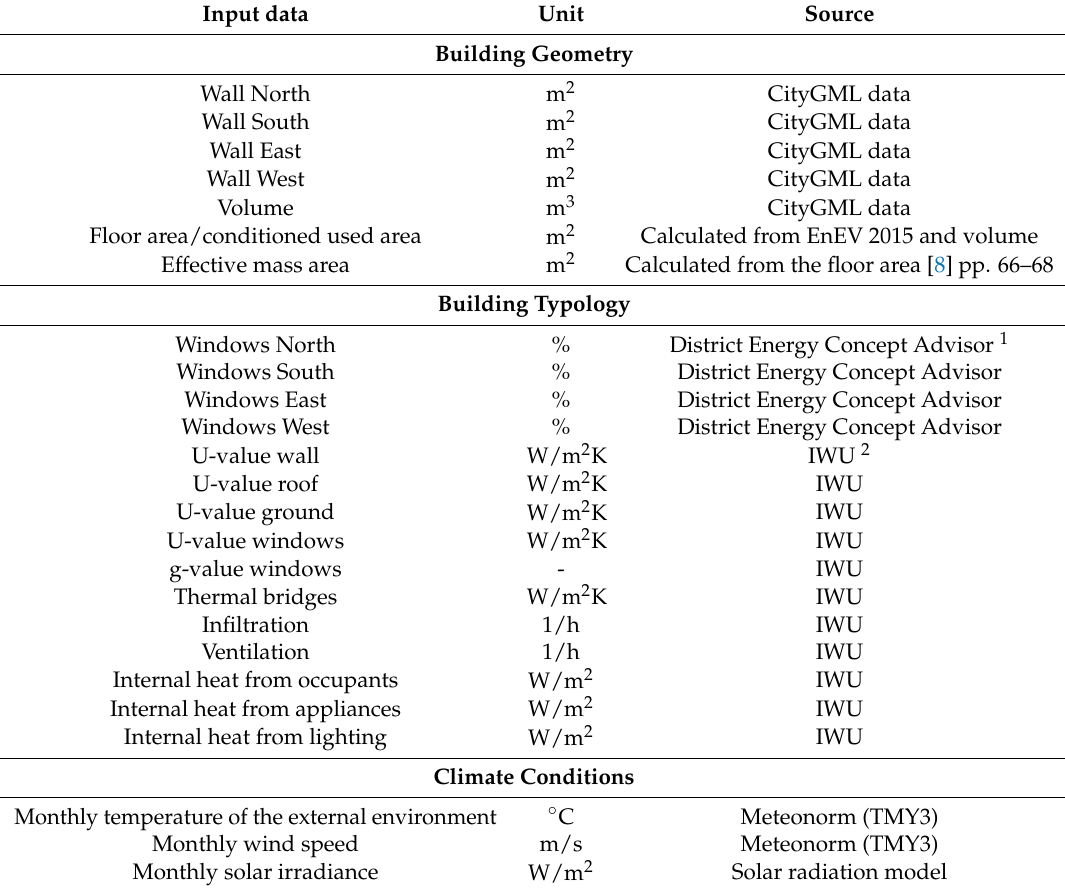
Table 1. Required input data and corresponding sources for the CityBEM monthly